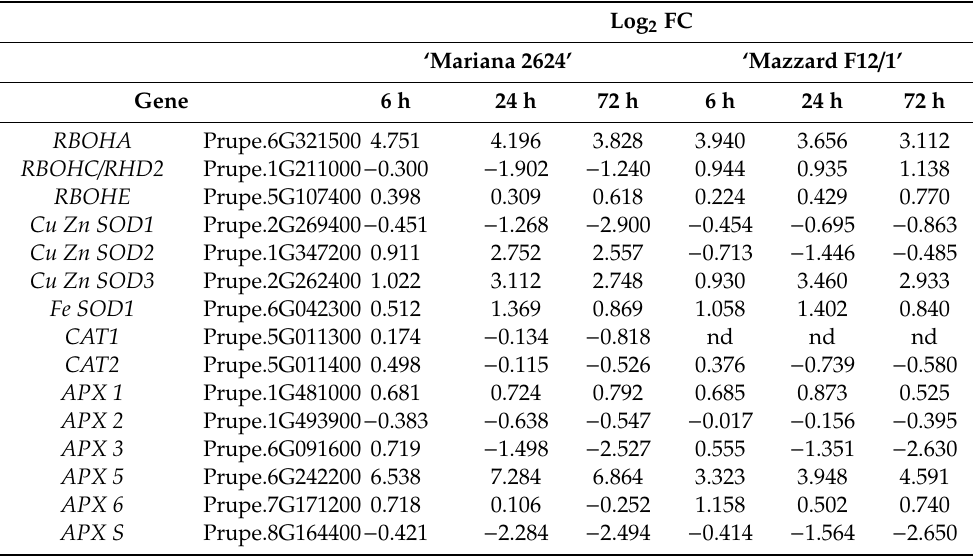
Table 1. Transcript levels (of genes related to ROS production ( RBOH ) and ROS scavenging ( SOD , CAT and APX )) from transcriptomics data from Prunus rootstocks under